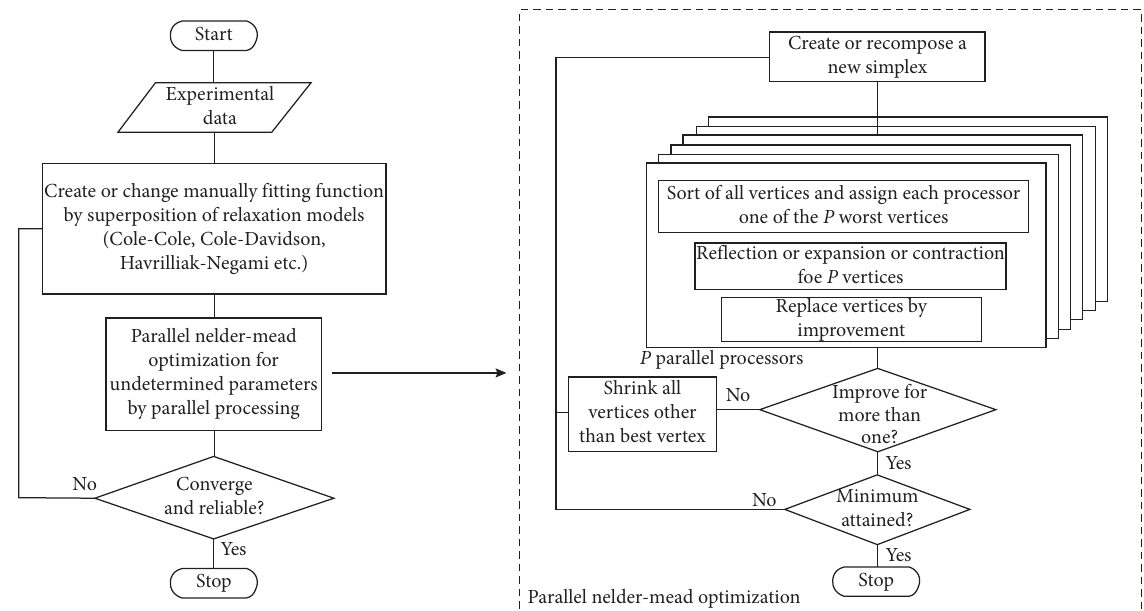
Figure 2: Algorithm of the dispersion analysis program, which employs parallel Nelder-Mead